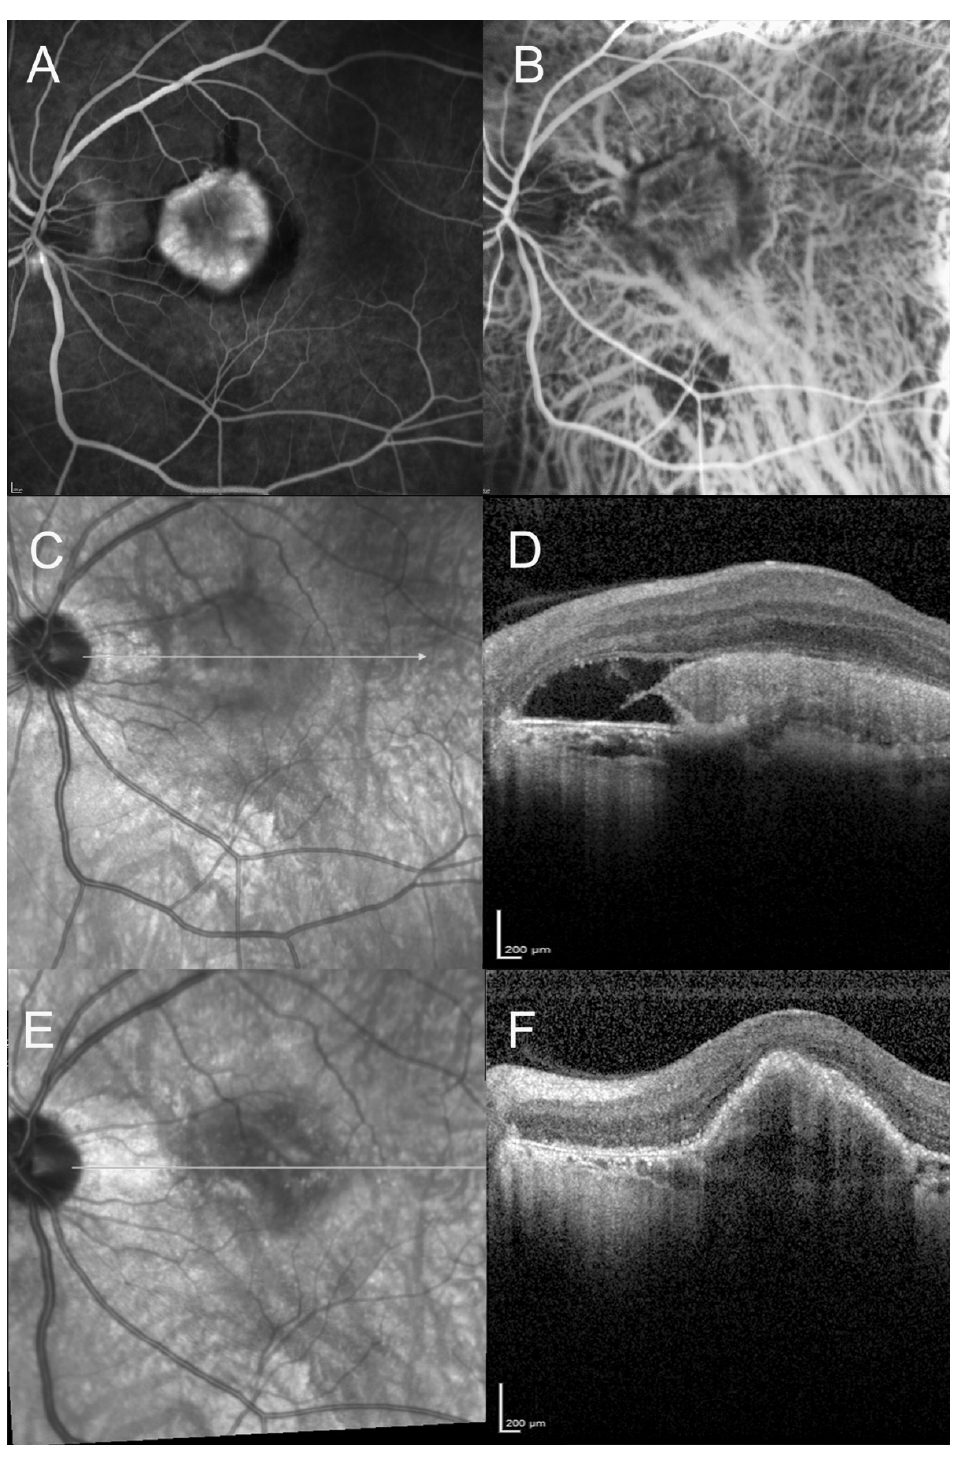
Figure 3. A 64-year-old man diagnosed with high myopia, presenting with visual acuity loss (20/100). ( A – D ): Fluorescein angiography, indocyanine green angiography, Infrared reflectance photography, and horizontal Spectral domain optical coherent tomography (SD-OCT) at baseline. Neovascular lesion in a myopic eye with tessellated fundus. SD-OCT scan showing the hyperreflective pre-epithelial neovascular lesion, with subretinal fluid. We can note the disruption of the retinal pigment epithelium (RPE) layer and the alteration of the photoreceptors layer. ( E , F ): Infrared reflectance photography and horizontal scan of the SD-OCT at 1-year follow-up, after anti-VEGF therapy. The fibrovascular PED can be observed. Visual acuity improved to 20/40.